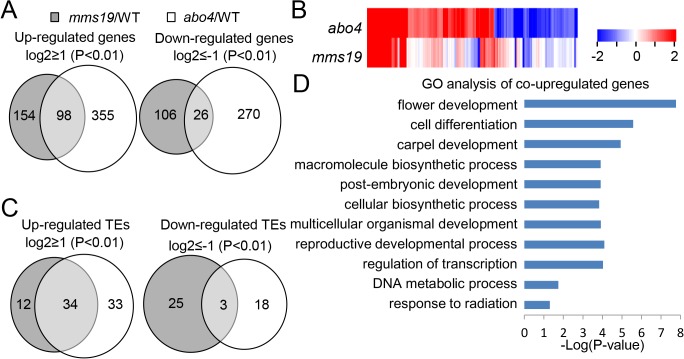
The effect of mms19 on the transcriptome as determined by RNA-seq analyses.(A) Differentially expressed genes in mms19 and abo4 mutants relative to the wild type are shown by Venn diagrams. (B) Differentially expressed genes in mms19 and abo4 mutants relative to the wild type are shown by heat maps. (C) Differentially expressed TEs in mms19 and abo4 mutants relative to the wild type are shown by Venn diagrams. (D) Gene Ontology (GO) analysis of co-upregulated genes in mms19 and abo4 mutants. The lengths of bars represent statistical values of gene enrichment in the indicated biological processes. The biological processes are listed only when their genes are significantly (P<0.05) enriched.